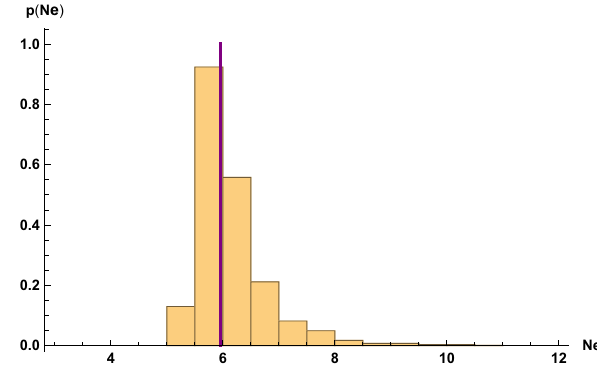
Fig. 1 Probablity distribution of the duration of the period of slow- roll inflation based on a set of 1000 simulations with the parameters √ 2 ,φ( 0 ) = 10 − 3 . The value of H was computed V 0 = 10 − 8 ,μ = 3 1 / 4 assuming that the potential energy dominates. The purple line indicates the value obtained neglecting the stochastic term